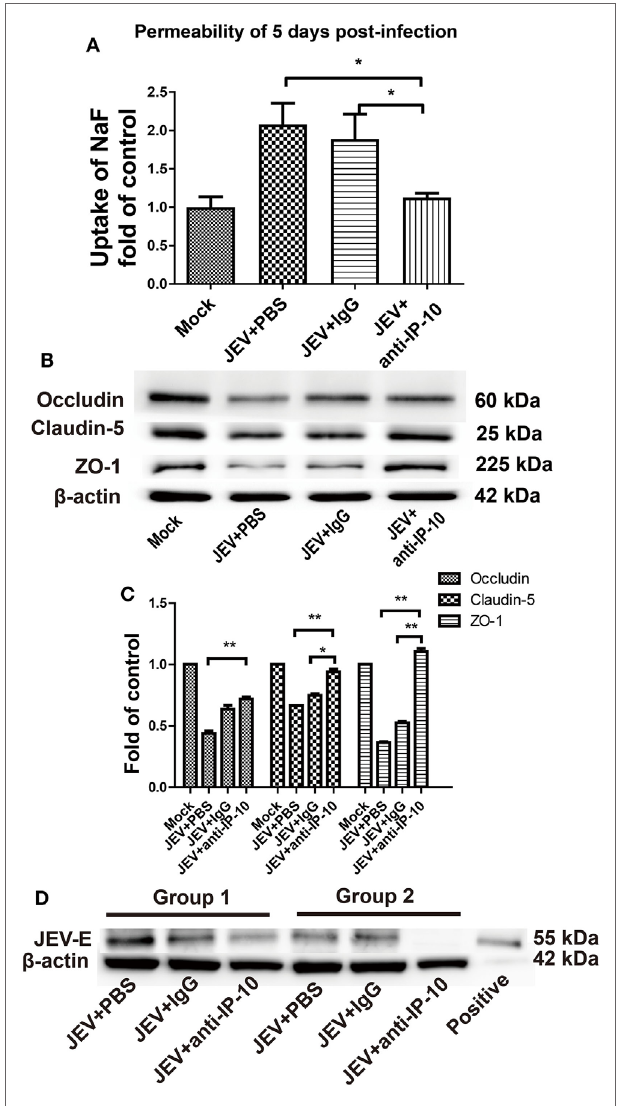
FigUre 2 | Effects of IP-10-neutralizing antibody on blood–brain barrier permeability during Japanese encephalitis virus (JEV) infection. (a) C57BL/6 mice were intravenously infected with 10 5 plaque-forming units of JEV-P3. On days 0, 2, and 4, the mice were intraperitoneally injected with anti-IP-10- neutralizing antibody, isotype antibody, or PBS. The mice were then sacrificed, and NaF uptake in the brain was measured on day 5 ( n = 5). (B) At the same time, JEV-infected brain samples from the C57BL/6 mice in panel (a) were collected, and the expression of tight junction (TJ) proteins were detected by Western blotting. (c) The expression of TJ proteins in panel (B) were normalized to β -actin expression and quantitatively analyzed as the fold-changes relative to that of the mock-infected controls ( n ≥ 4). (D) The expression of the envelope protein of JEV in mouse brains was measured by Western blotting ( n ≥ 3). Groups 1 and 2 represent two independent groups of mice. The data are expressed as the means ± SEMs. * p < 0.05; ** p <